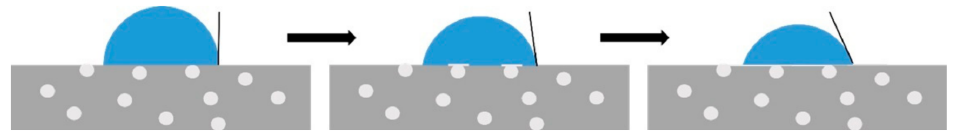
Figure 10. Scheme for auto-spread of H-PAAS-LHL between water and surface.